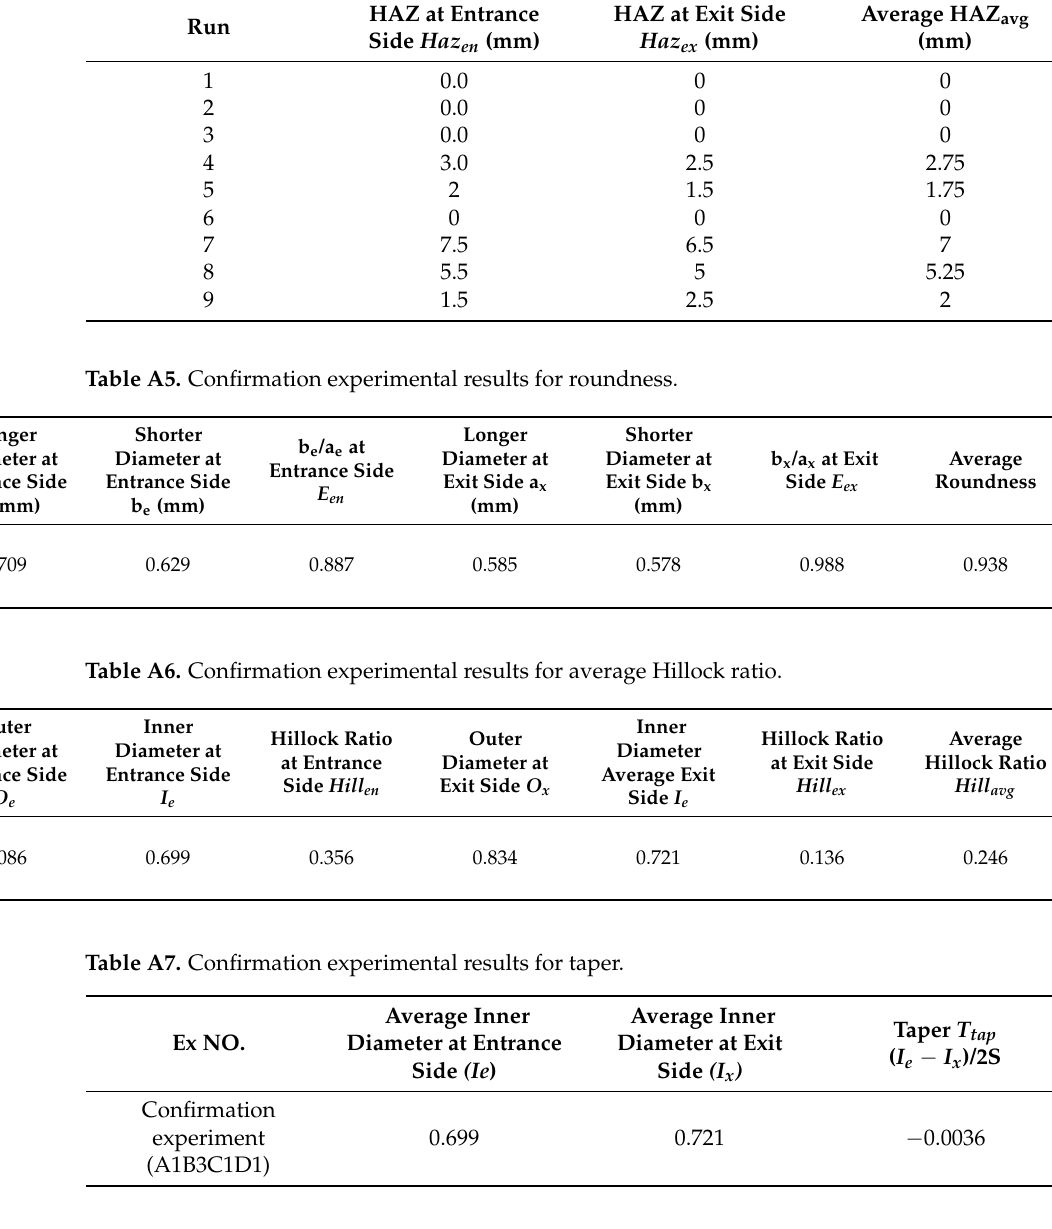
Table A8. Confirmation experimental results for HAZ avg